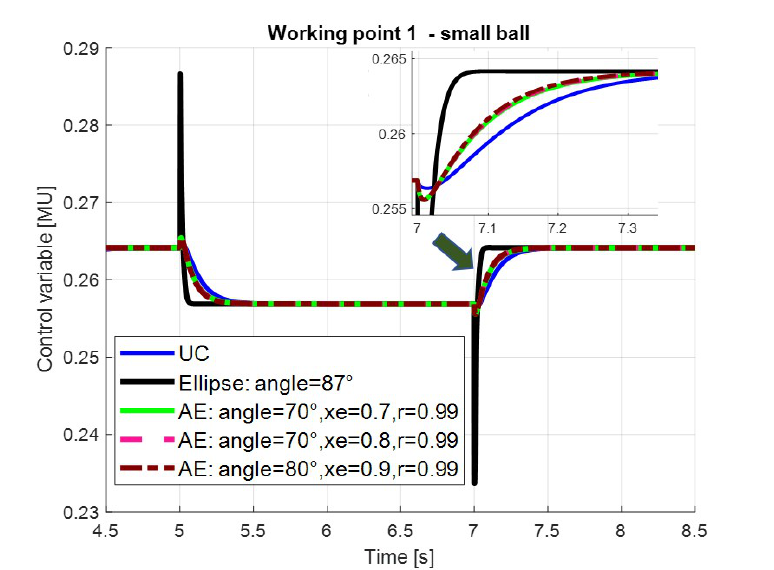
Figure 5. Control variable responses simulated on nonlinear model for the 1st working point (small ball) with the proposed pole-placement controllers according to